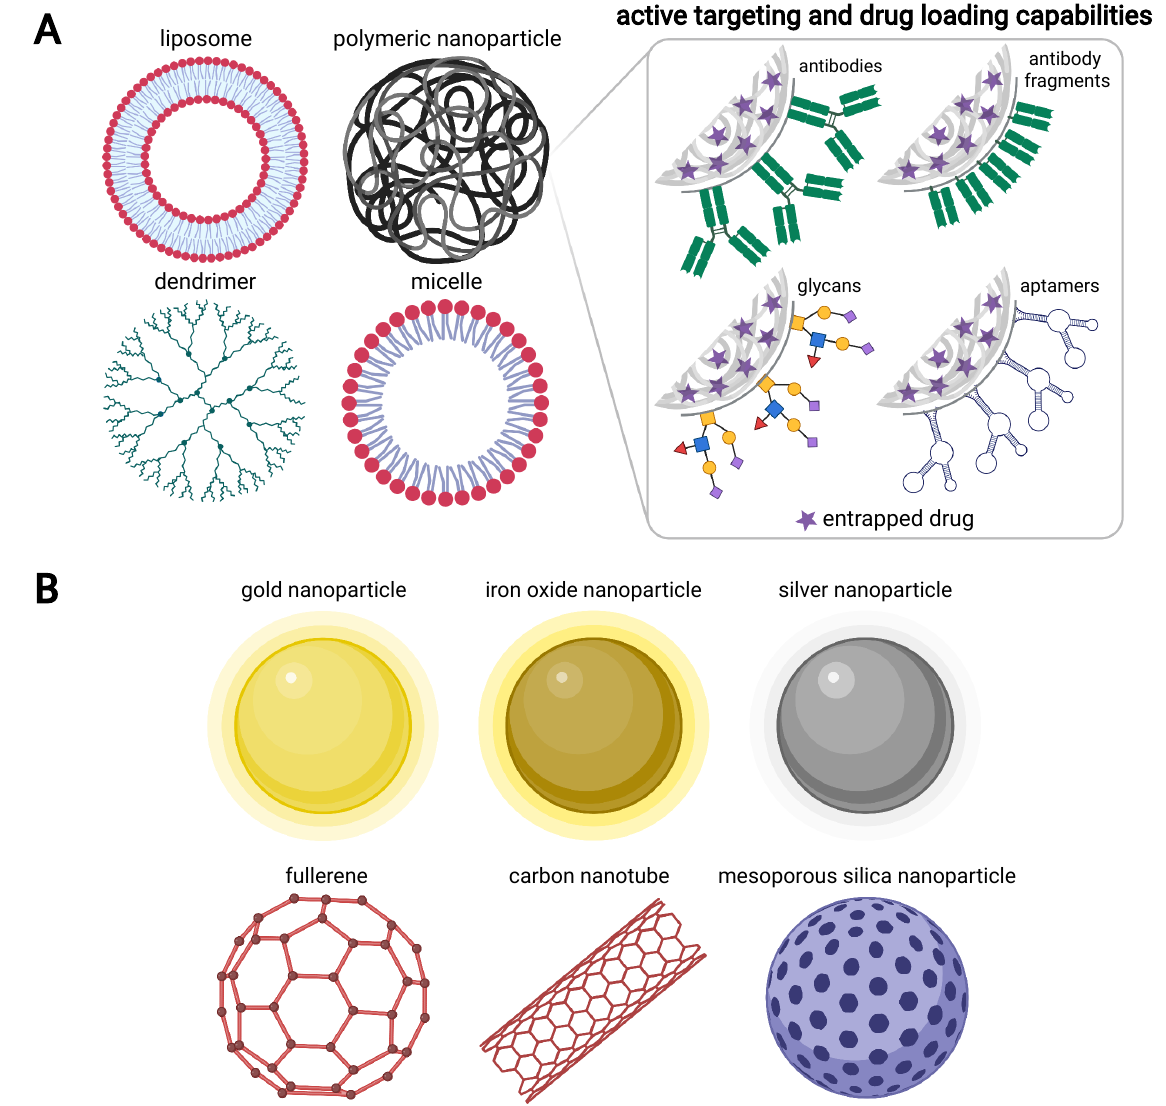
Figure 1. Selected examples of organic and inorganic nanoparticles. ( A ) Organic materials used for nanoparticle construction include lipids and polymers of natural or synthetic origin. Nanoparticles within this class are commonly exploited as drug delivery vehicles and may be functionalised with ligands to enhance targeting to cell surface receptors, as shown for polymeric nanoparticles. ( B ) Inorganic materials used for nanoparticle construction include carbon, silica and metals such as gold, silver and iron oxide. Nanoparticles within this class are commonly exploited for diagnostic and imaging purposes, although they may also be deployed as therapeutics given their capacity for drug loading and their unique physicochemical properties that facilitate approaches such as photothermal tumour ablation. As illustrated in ( A ), targeting ligands may be similarly conjugated to inorganic nanoparticles. Although selected examples are shown, many other types of organic (e.g., polymersomes and solid lipid nanoparticles) and inorganic (e.g., quantum dots and lanthanide-doped upconversion nanoparticles) platforms have been developed for wide-ranging biomedical applications. Much diversity exists between the various types of nanoparticles, particularly with regard to size. For example, diameters of <100 nm are typically observed for dendrimers, micelles and gold nanoparticles, whereas liposomes and polymeric nanoparticles often measure >100 nm. Many of the clinically approved nanomedicines fall within the latter size range, with diameters of 110 nm and 130 nm reported for Onivyde and Abraxane,